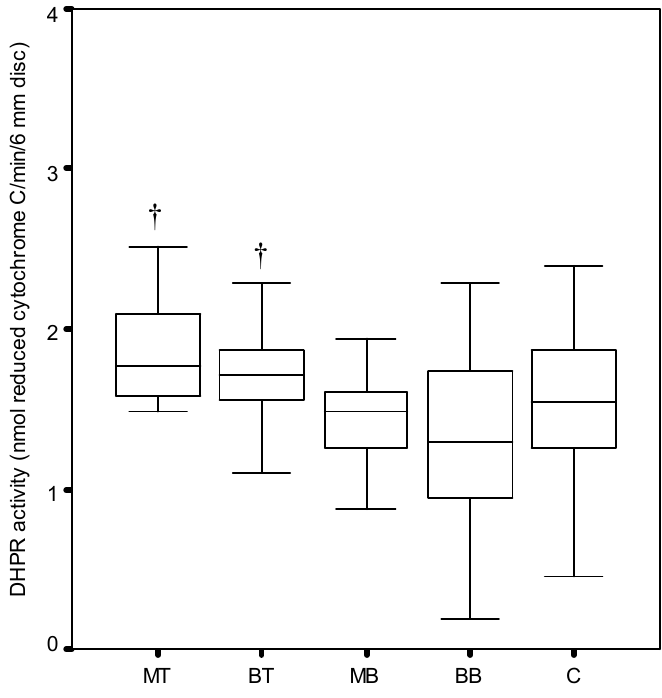
Figure 3. Box plots of blood dihydropteridine reductase (DHPR) activities of the patients groups (shown are medians = horizontal lines, interquartile ranges = boxes, and ranges = bars). MT, malign thyroid (n = 17); BT, benign thyroid (n = 42); MB, malign breast (n = 24); BB, benign breast diseases (n = 19), and C, control group (n = 30). †p < 0.05 vs. control